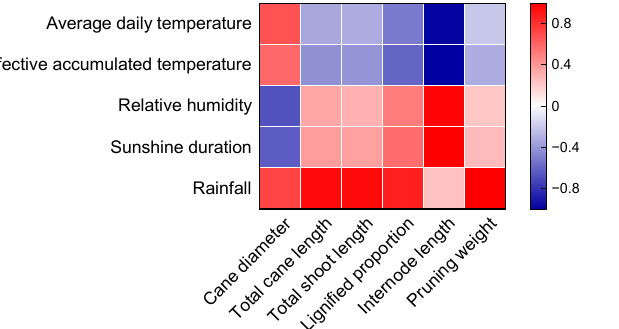
Figure 3. Heat maps of the correlations between growth-related traits of the adult vines and the meteorological factors.